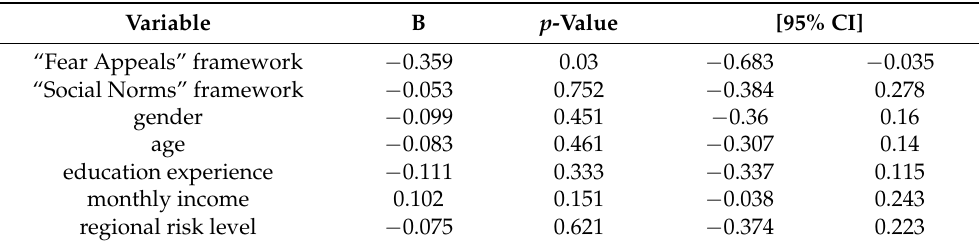
Table A7. Linear regression model of perceived social pressure on risk communication frameworks, n = 165.